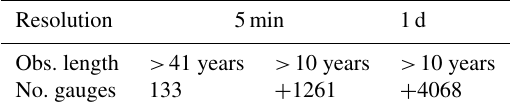
Table 1. Number of stations for each of the available data types in Germany: long series (LS), short series (SS) and daily series